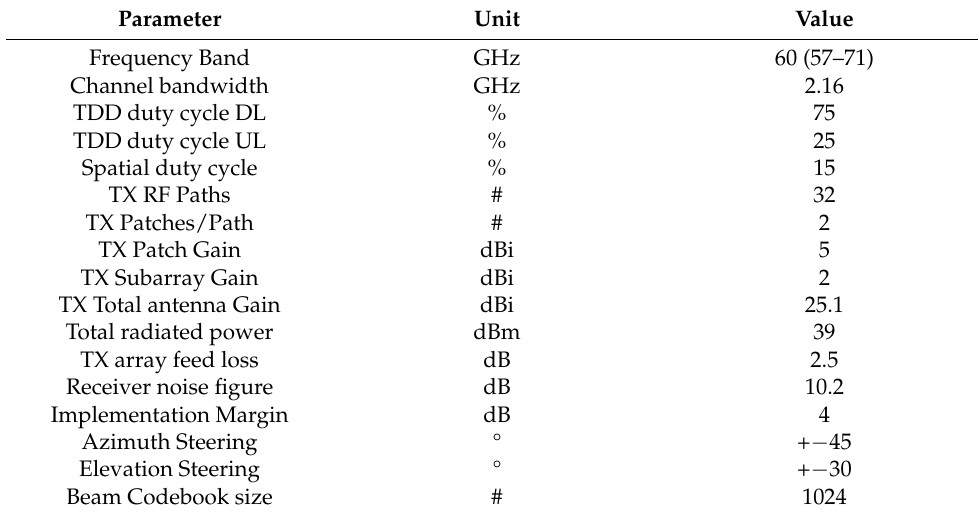
Table 3. Transceiver network parameters for the